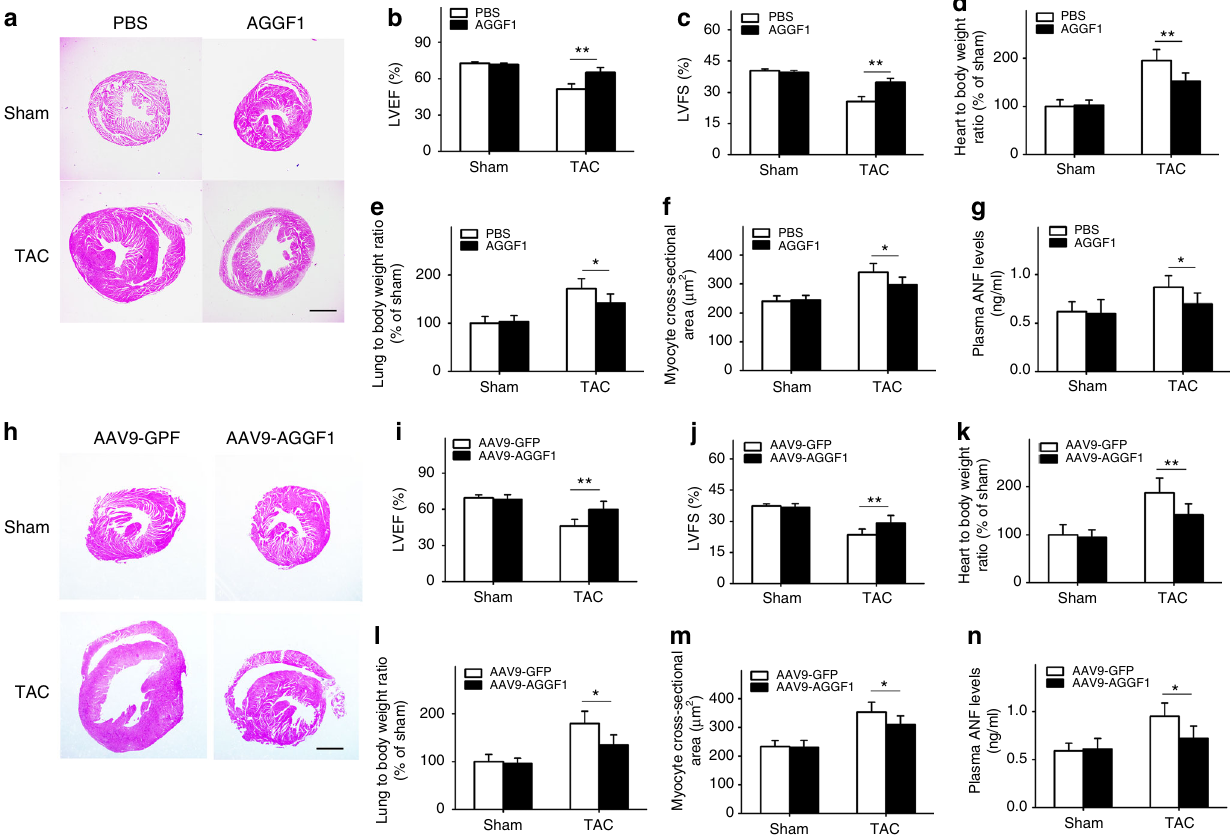
Fig. 3 AGGF1 therapy of TAC mice with cardiac hypertrophy. a – g AGGF1 protein therapy; h – n AGGF1 gene therapy using AAV9 viruses ( n = 12 per group, * P < 0.05, ** P < 0.01). a , h H&E staining images of heart tissues. Scale bar , 1 mm. ( b , i ) Echocardiographic data on LVEF. c , j Echocardiographic data on LVFS. d , k The ratio of heart weight to body weight. e , l The ratio of lung weight to body weight. f , m The cross-sectional diameter ( µ m) of cardiomyocytes. g , n Plasma ANF levels. Data are presented as the mean ± s.d. from at least three independent experiments. Statistical analysis was carried out by a Student ’ s two-tailed t